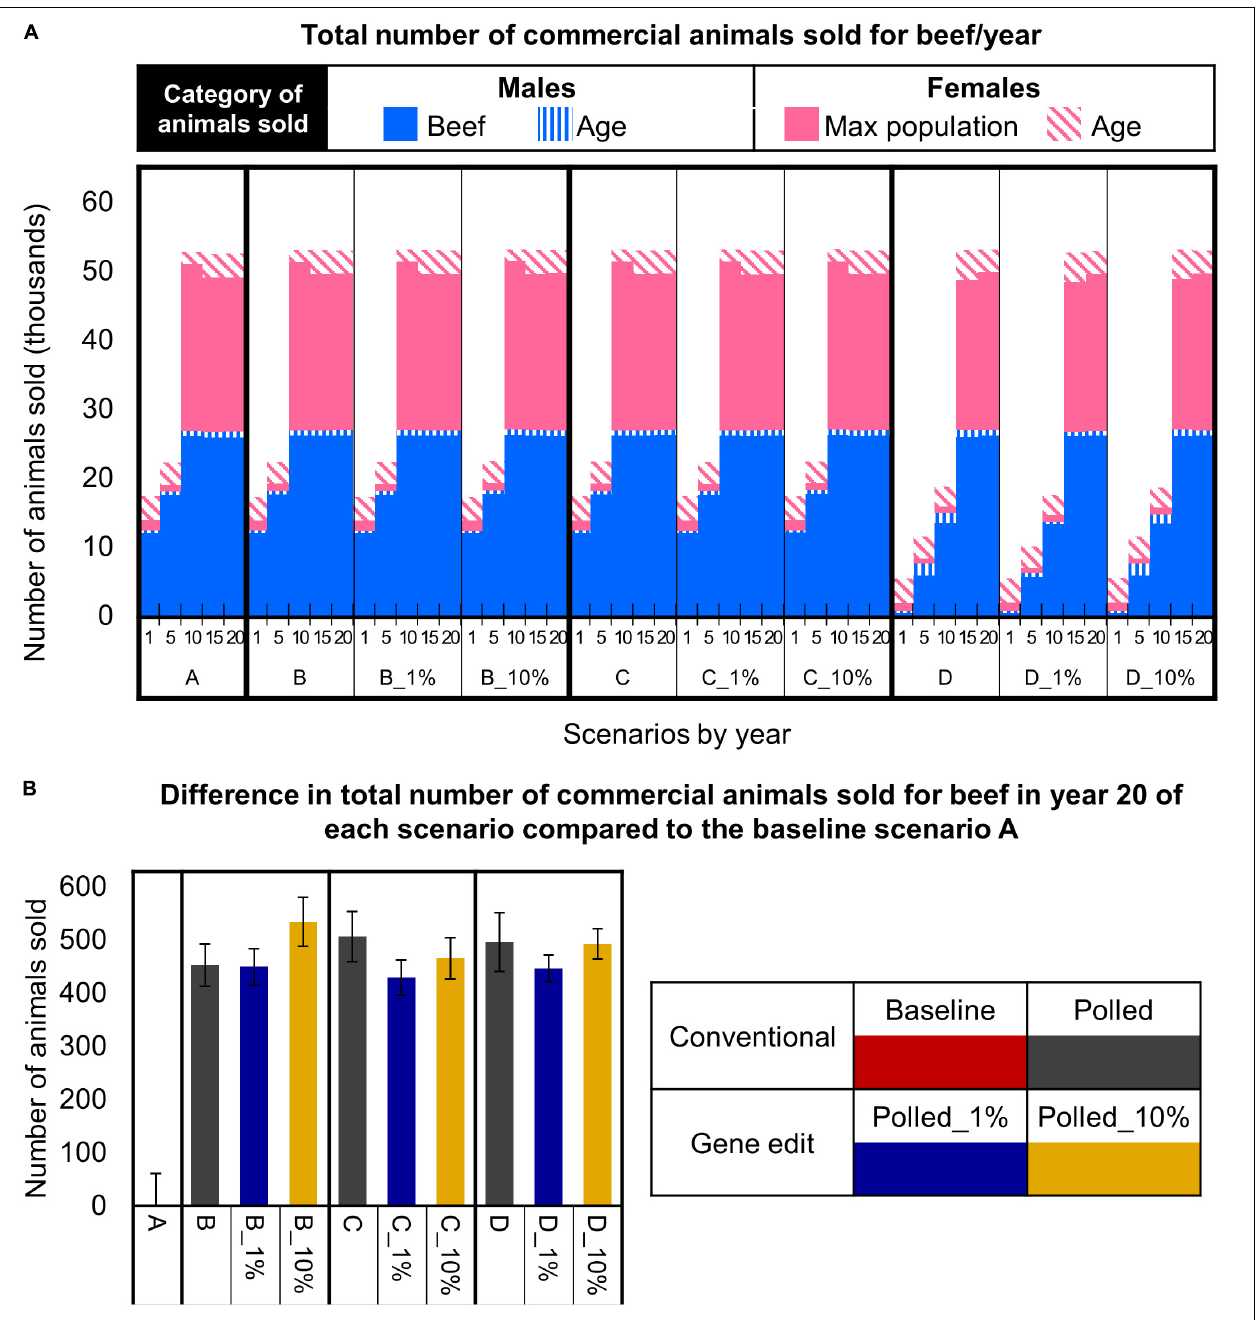
FIGURE 8 | Effect of each scenario on the total number of commercial animals sold for beef. (A) Number and category of animals sold in year 1, 5, 10, 15, and 20 for each scenario. (B) The difference in the number of animals sold in year 20 for each polled mating scenario compared to the baseline A scenario. Error bars represent